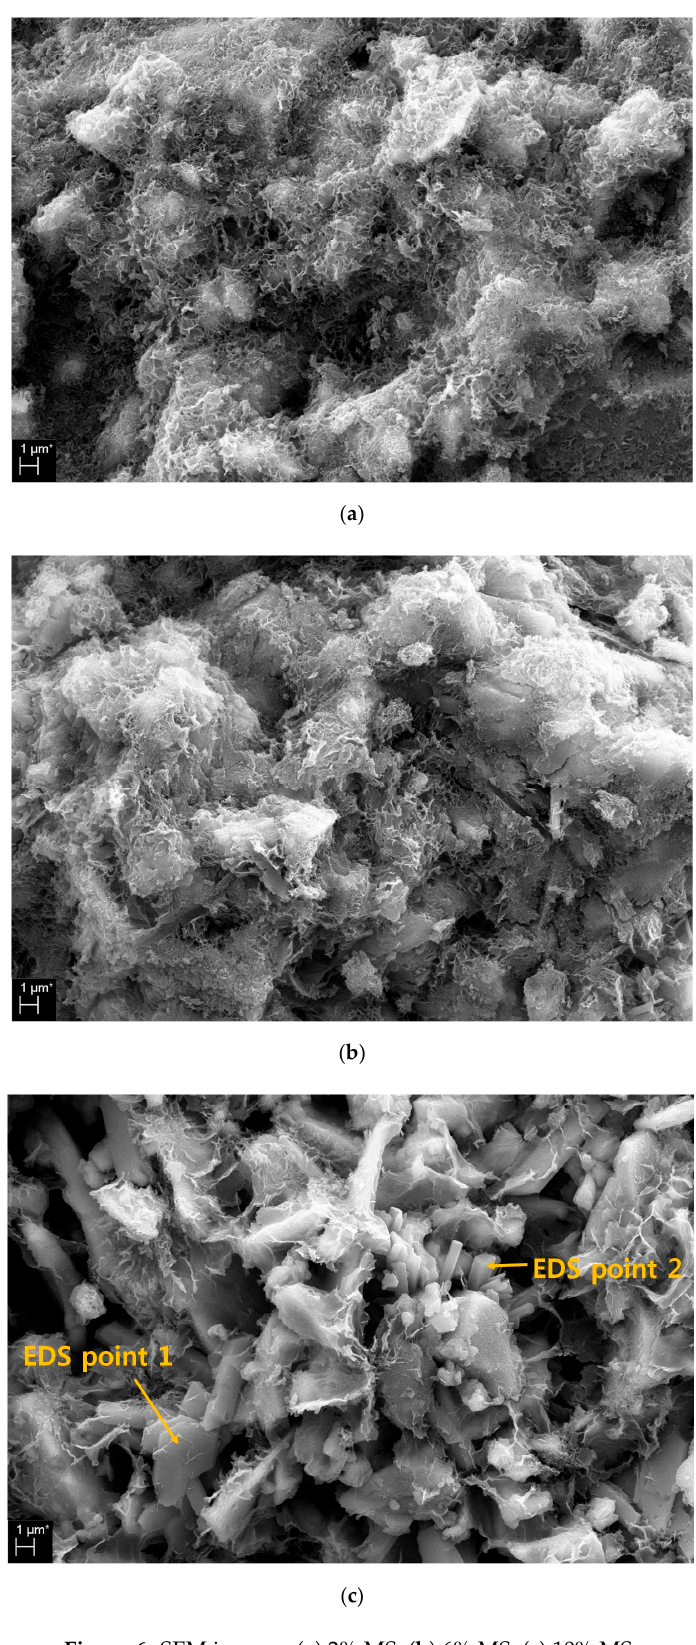
Figure 6. SEM images: ( a ) 2% MS, ( b ) 6% MS, ( c ) 10% MS.